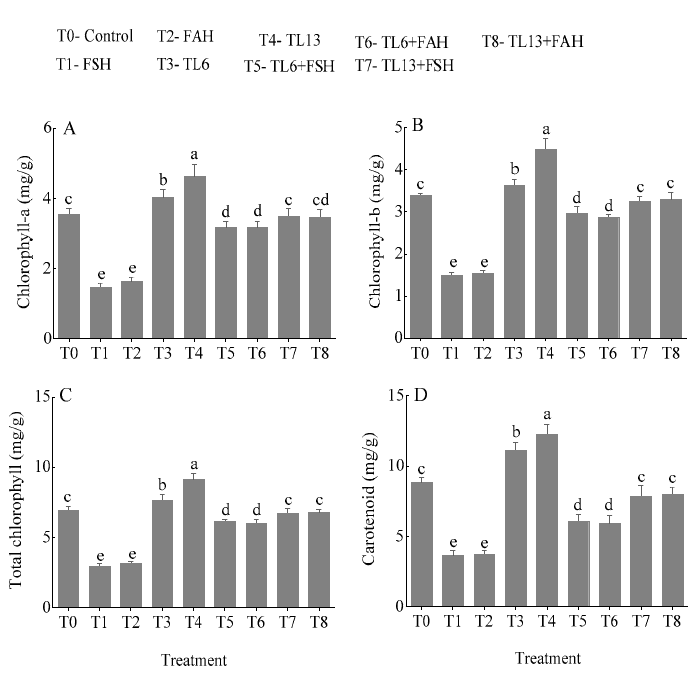
Figure 7. Effects of TL6 and TL13 treatment on ( A ) chlorophyll a, ( B ) chlorophyll b, ( C ) total chlorophyll, and ( D ) carotenoid content in the leaves of snow pea plants under F. solani (FSH) and F. avenaceum (FAH) stress. Data are presented as mean ± standard errors (SE) of two independent experiments in three replicates. Means with the same lowercase letters are not significantly different at p < 0.05, according to Duncan’s multiple range tests.